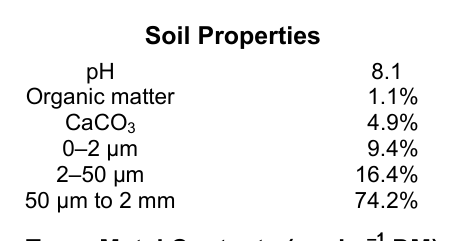
Characteristics of the Investigated